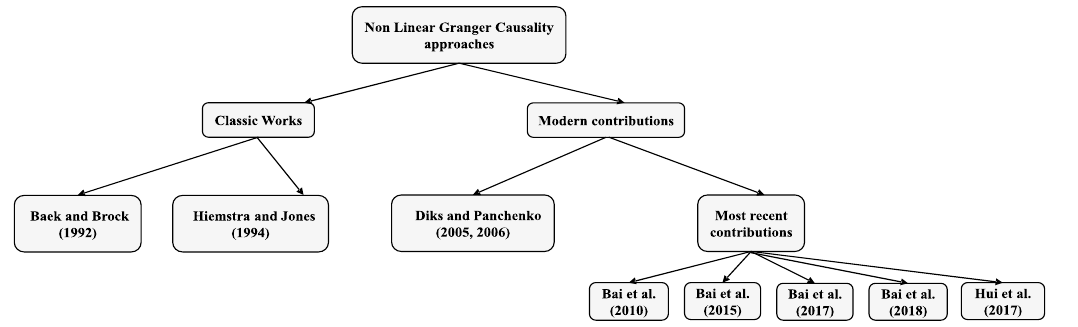
Figure 1. Non-linear Granger causality approaches summary. Source: Own